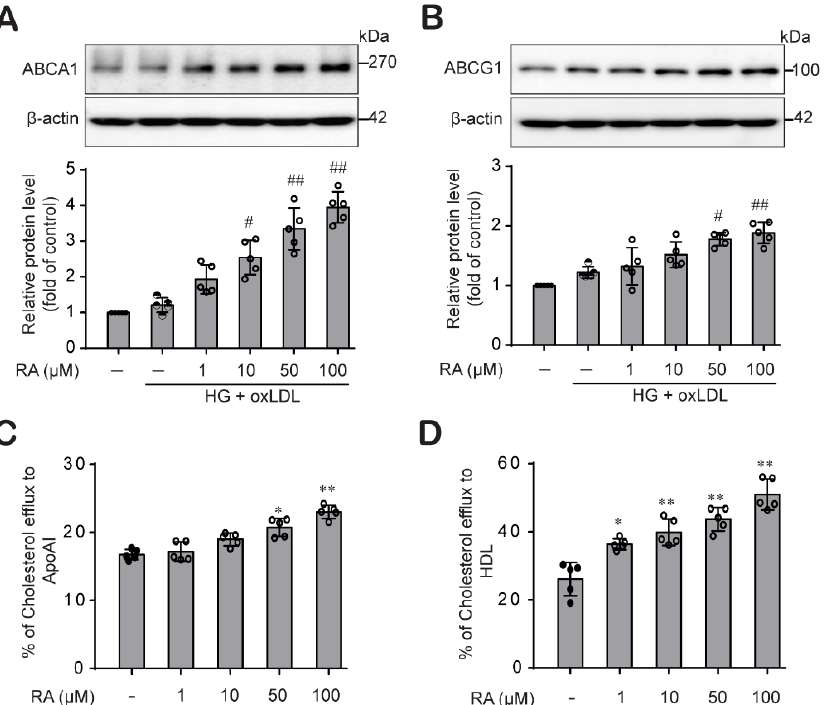
Figure 2. RA enhanced ABCA1 and ABCG1 protein levels and promoted cholesterol efflux in THP-1 macrophages. THP-1 macrophages cultured under HG conditions (25 mM) for 48 h were stimulated with oxLDL (100 µ g/mL) for an additional 24 h in the presence or absence of RA (1, 10, 50 and 100 µ M). Cell lysates were collected to determine ABCA1 ( A ) and ABCG1 ( B ) protein levels by western blot analysis. Band densities were quantified, and relative protein levels are presented as the mean ± SD of five independent experiments. ( C , D ) THP-1 macrophages were labeled with cholesterol and equilibrated for 24 h in the presence or absence of RA (1, 10, 50 and 100 µ M). Cholesterol efflux was evaluated in THP-1 macrophages after 6 h of incubation with ApoA1 ( C ) or HDL ( D ) as described in the Methods section. The data are presented as the mean ± SD of five independent experiments. * p < 0.05, ** p < 0.01 compared to the control; # p < 0.05, ## p < 0.01 compared to the HG + oxLDL